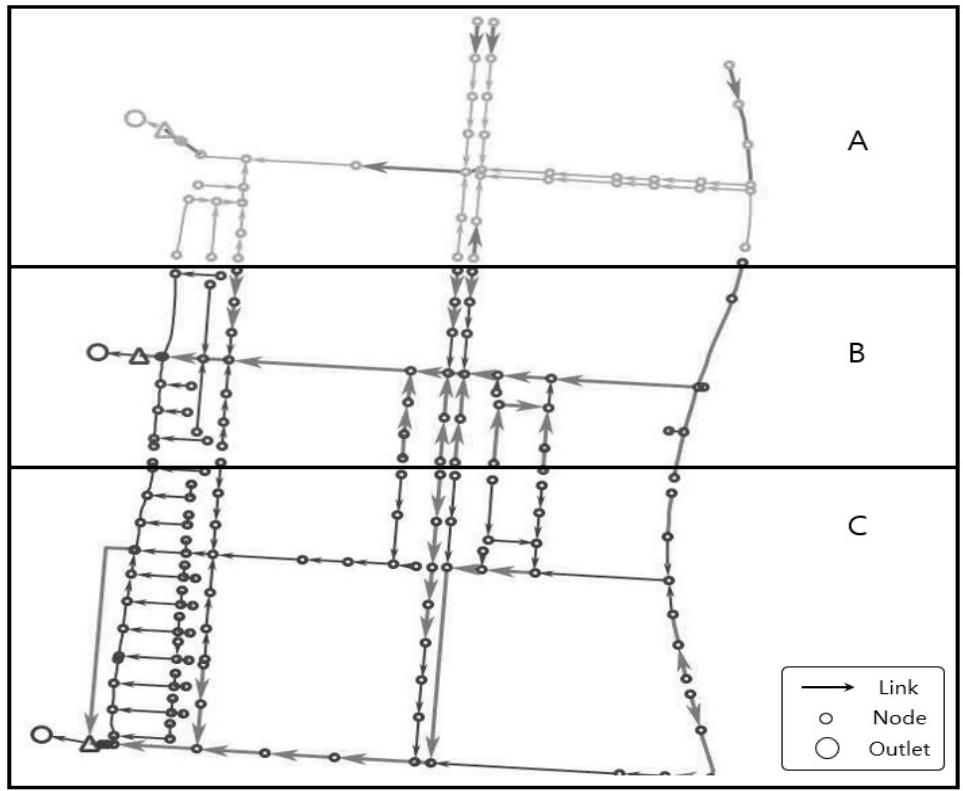
Figure 4. Pipe network of watersheds. ( A ) Outlet of section A; ( B ) Outlet of section B; ( C ) Outlet of section C